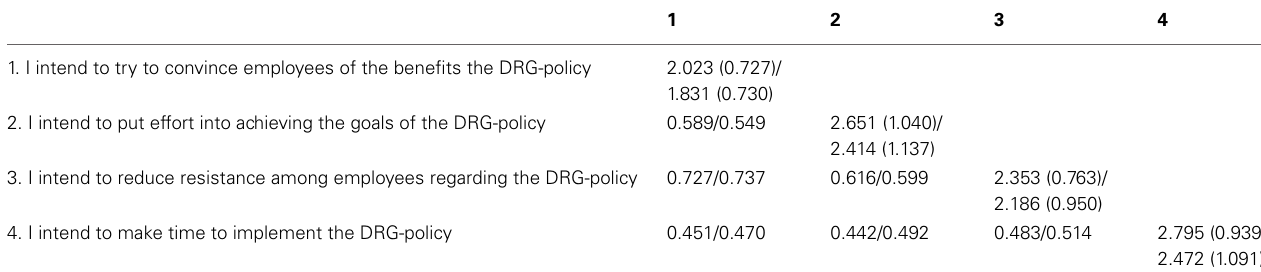
Table 1 | Correlation matrix for Psychologists ( n = 570) and Psychiatrists ( n = 504) with the means (variances) on the diagonal.